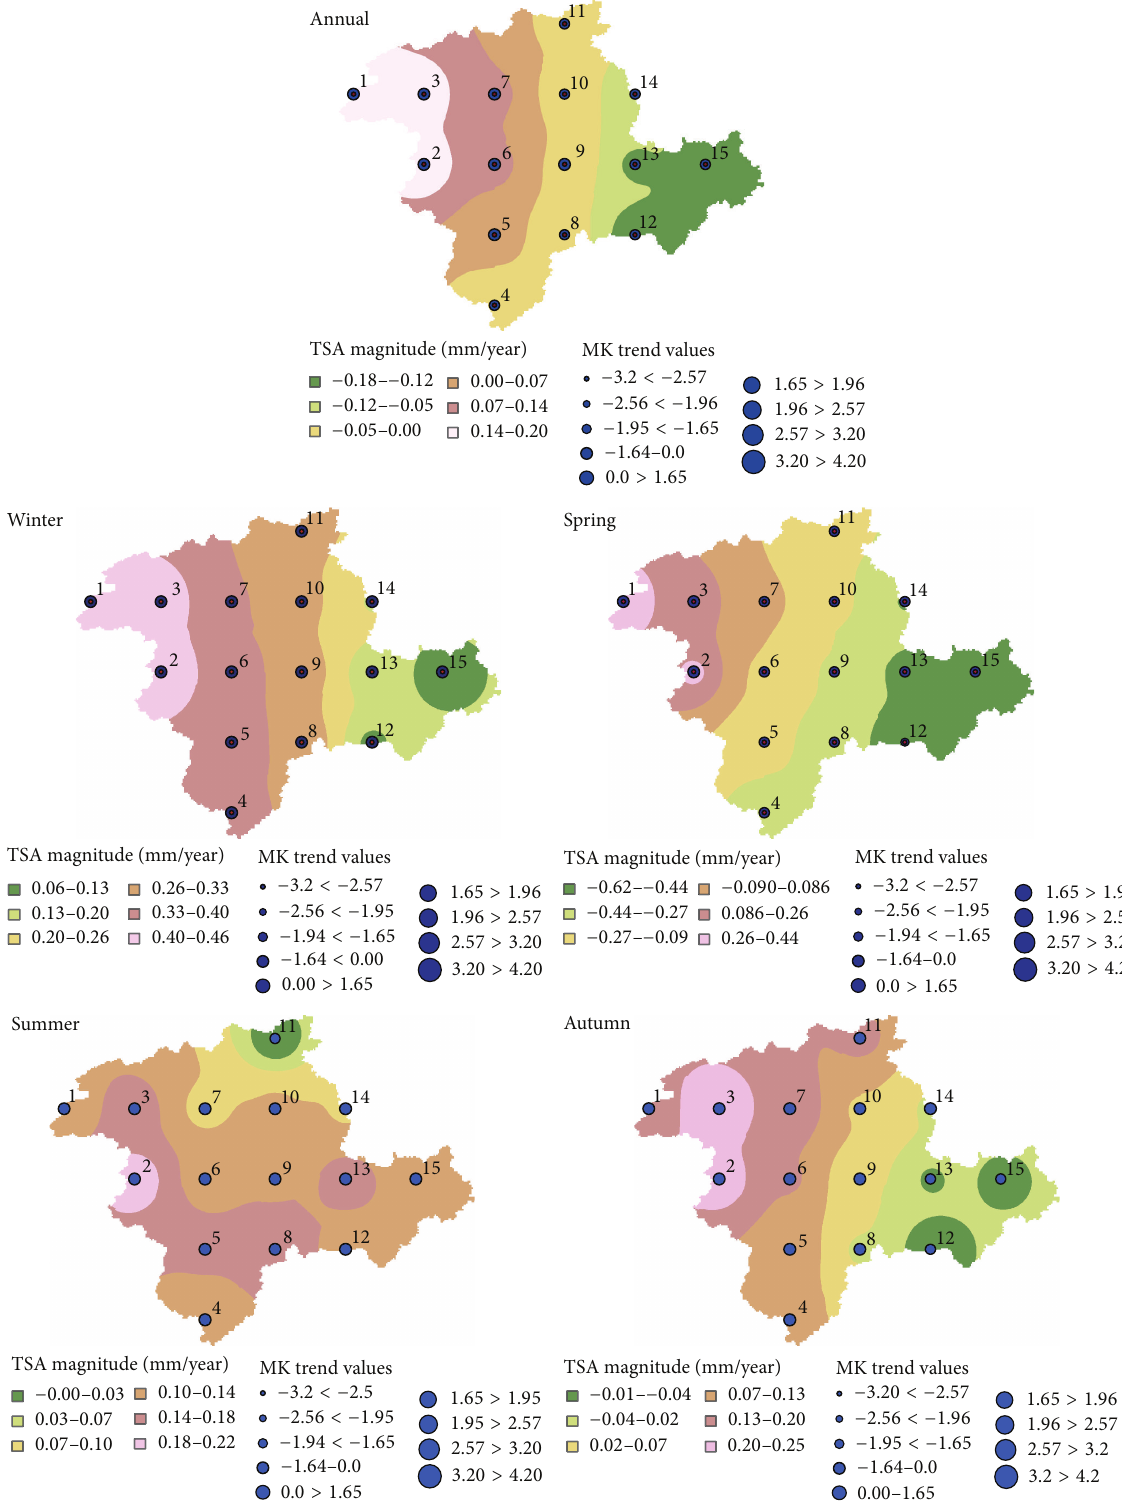
Figure2:SpatialdistributionofstationswithMKtestresultsandinterpolatedTSAmagnitude(mm/year)ofannualandseasonalprecipitation data series over the period of